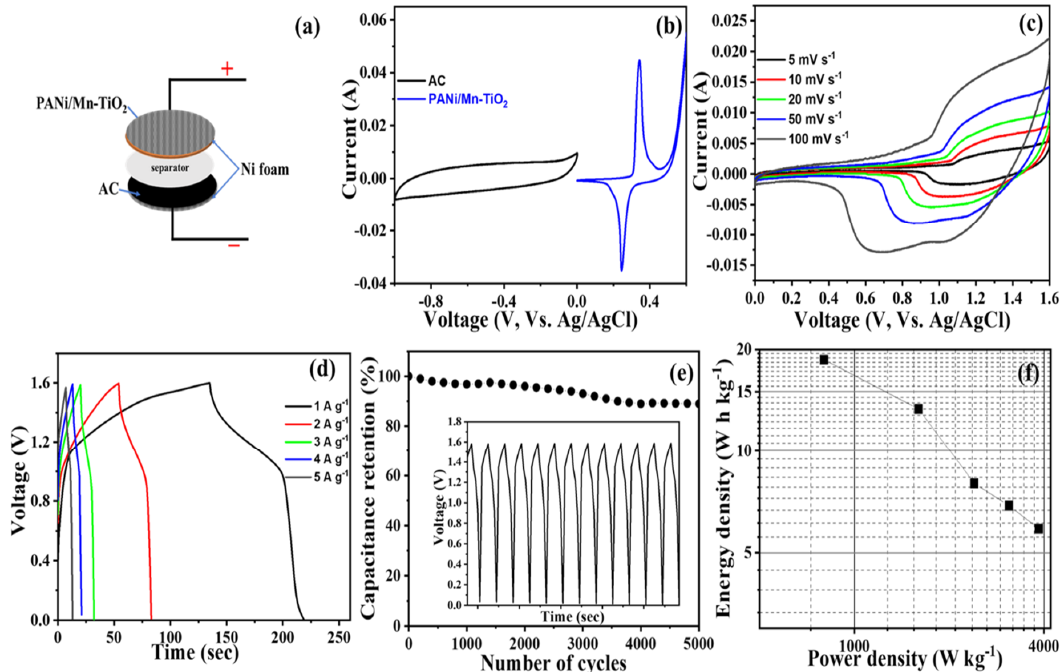
Figure 6. Asymmetric supercapacitor device performance, ( a ) schematic representation of assembled asymmetric device, ( b ) CV plot of AC and PANi/Mn-TiO 2 at 5 mV s −1 , ( c ) CV curve of asymmetric device at different scan rates, ( d ) charge discharge profiles of asymmetric device at various current densities, ( e ) life cycle stability of asymmetric device at 10 A g −1 (inset shows few final charge discharge cycle), ( f ) Ragone plots.